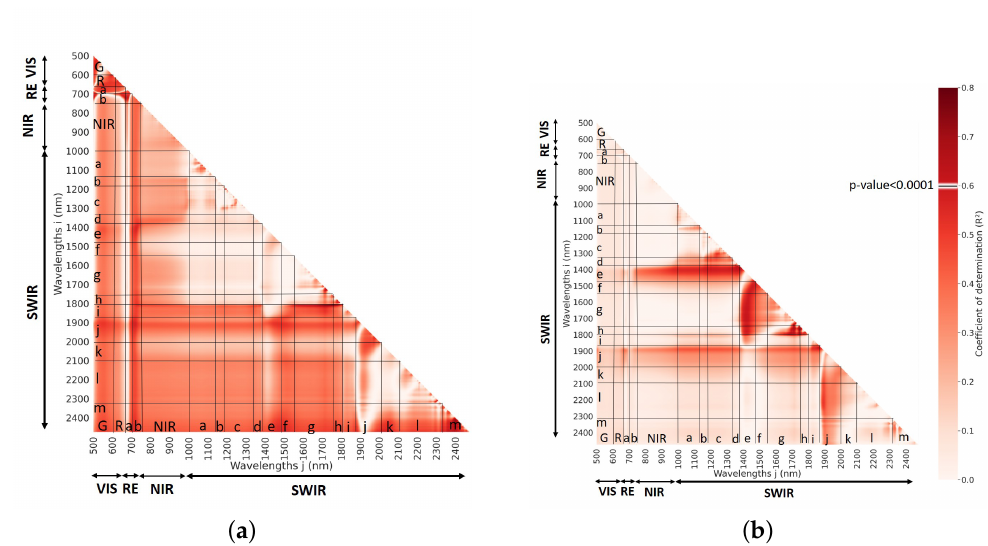
Figure 17. Correlation matrix showing the coefficient of determination between NDSI’s results and SWP when considering only plots A and C (left) or only plot B (right). The spectral domains defined in Table 6 are also reported along the two axes. ( a ) Plots A and C; ( b ) Plot B.